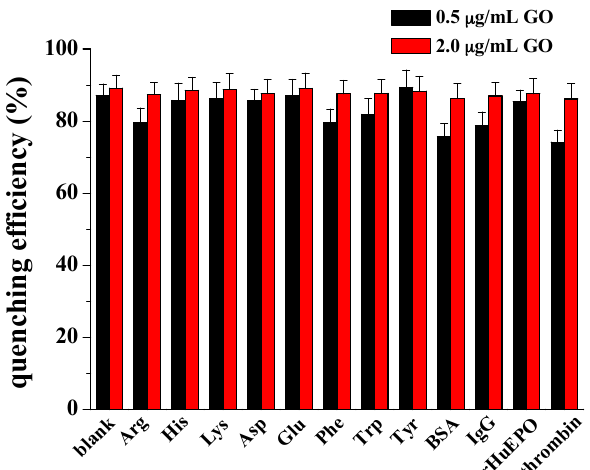
Figure 2. Effects of various amino acids and proteins on the quenching efficiency of 0.5 and 2 µ g/mL GO to FITC-PPLRINRHILTR. The final concentrations of FITC-PPLRINRHILTR, amino acids and proteins were 50 nM, 50 µ M and 10 ng/mL, respectively.